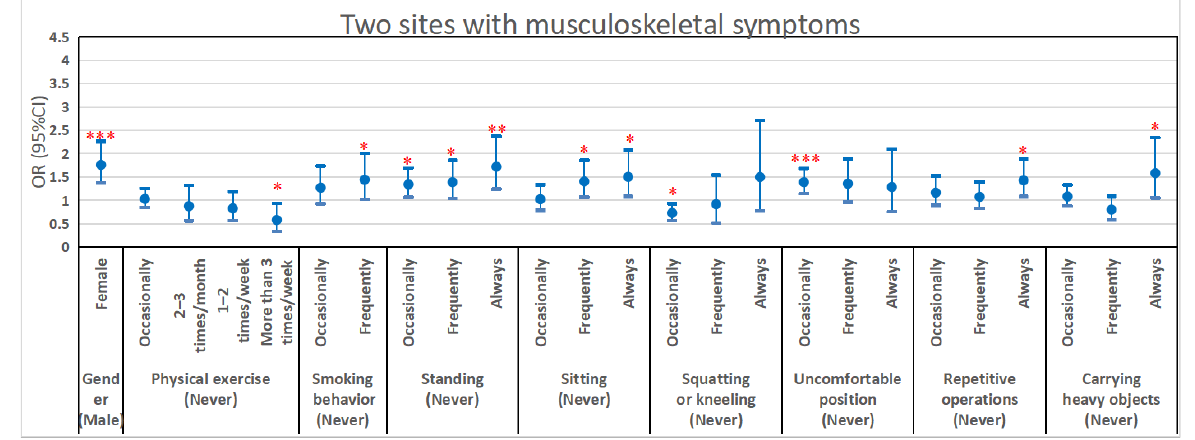
Figure 1. Multivariate logistic regression analysis describing the associations between demographic and work-related factors with two body sites musculoskeletal symptoms. Notes: *, p < 0.05; **, p < 0.01; ***, p < 0.001. Models consisted of age, gender, monthly income (RMB), marital status, physical exercise, smoking status, job tenure (years), standing for long period at work, sitting for long period at work, squatting or kneeling for long period at work, working in an uncomfortable position, performing the repetitive operations per minute, carrying heavy objects >5 Kg, exerting great force with arms or hands, use vibrating tools at work and working in cold or temperature changing environments.